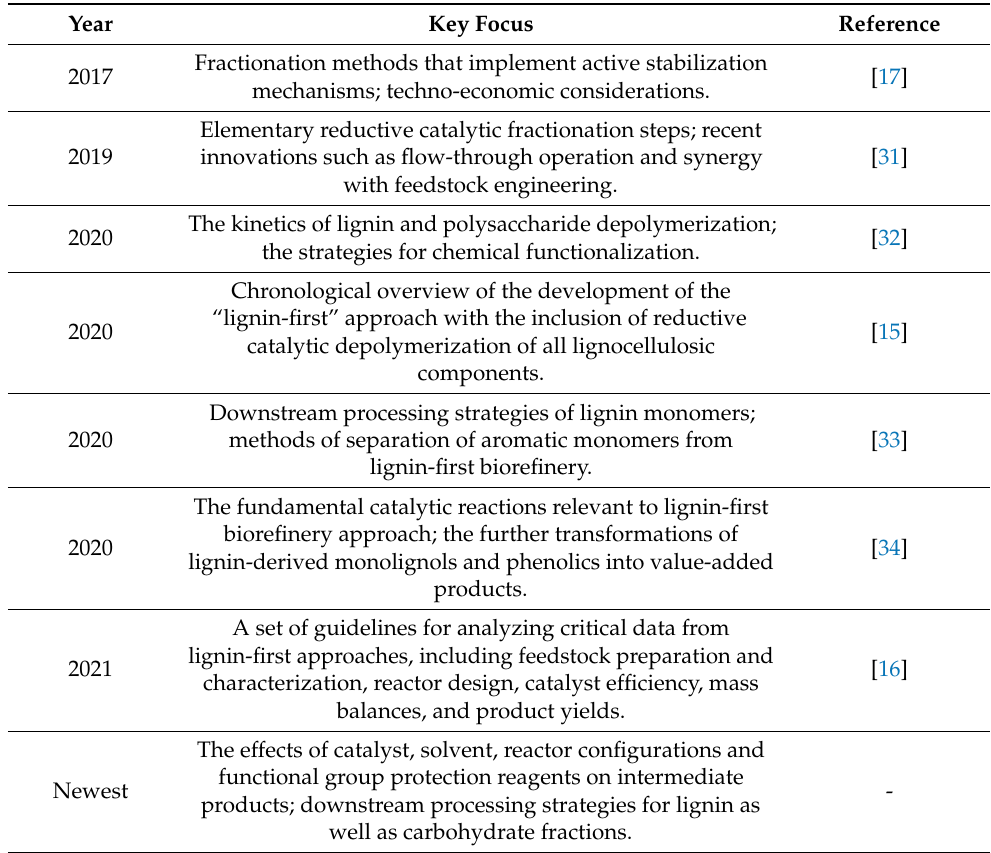
Table 1. Summary of notable works previously published that are relevant to lignin-first biorefinery.